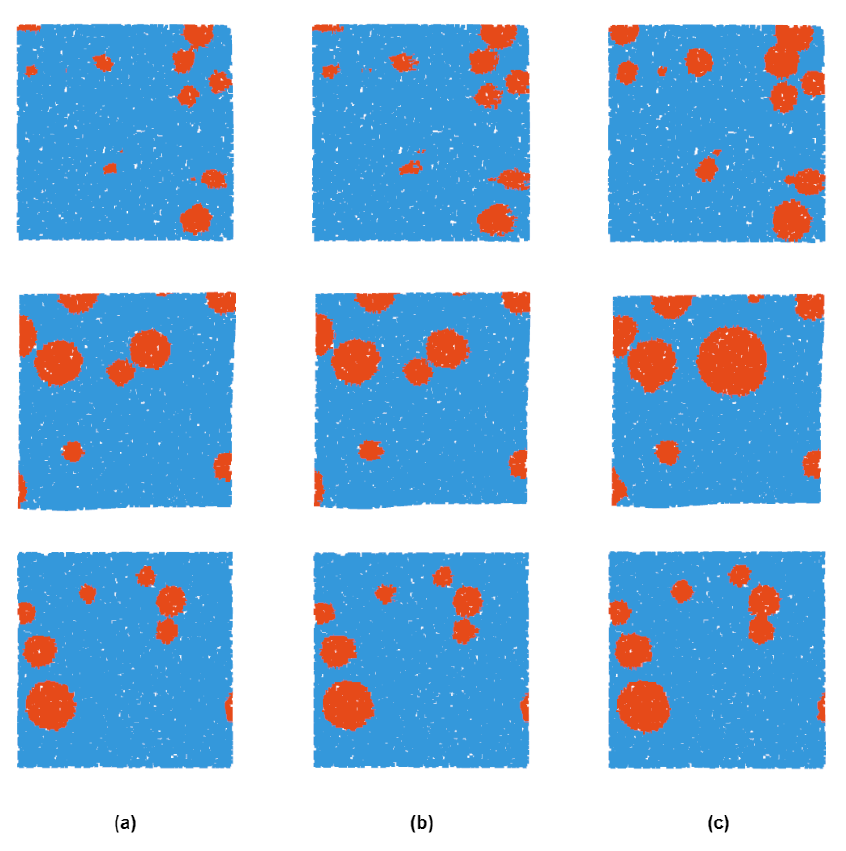
Figure 8. Illustration of the post-processing results. ( a ) shows the preliminary detection results of the pre-detection module. The result of ( a ) after Dilating Processing is shown in ( b ). ( c ) is the final detection result after Boundary Extraction. As indicated from the image on the first line, the Post- Processing method is capable of improving the situation that the detection results are concentrated in the center of the impact crater. As shown in the three lines, for the effective preliminary detection results, the Post-Processing module does not exert much